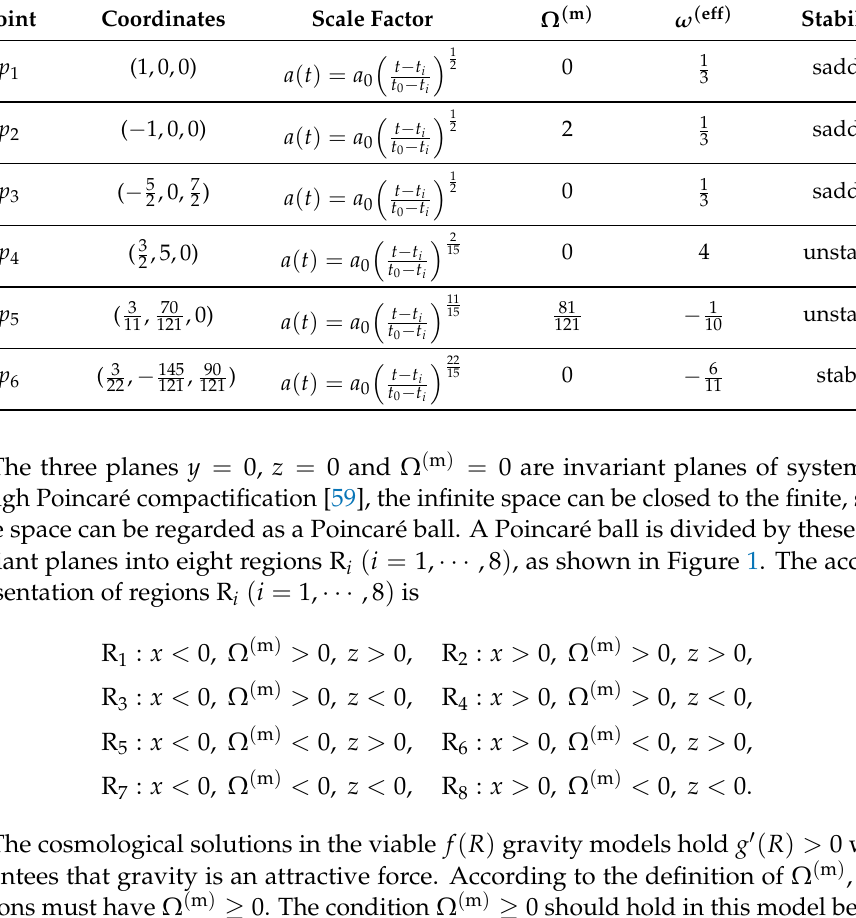
Table 1. The finite equilibrium points of the dynamical systems. Point Coordinates Scale